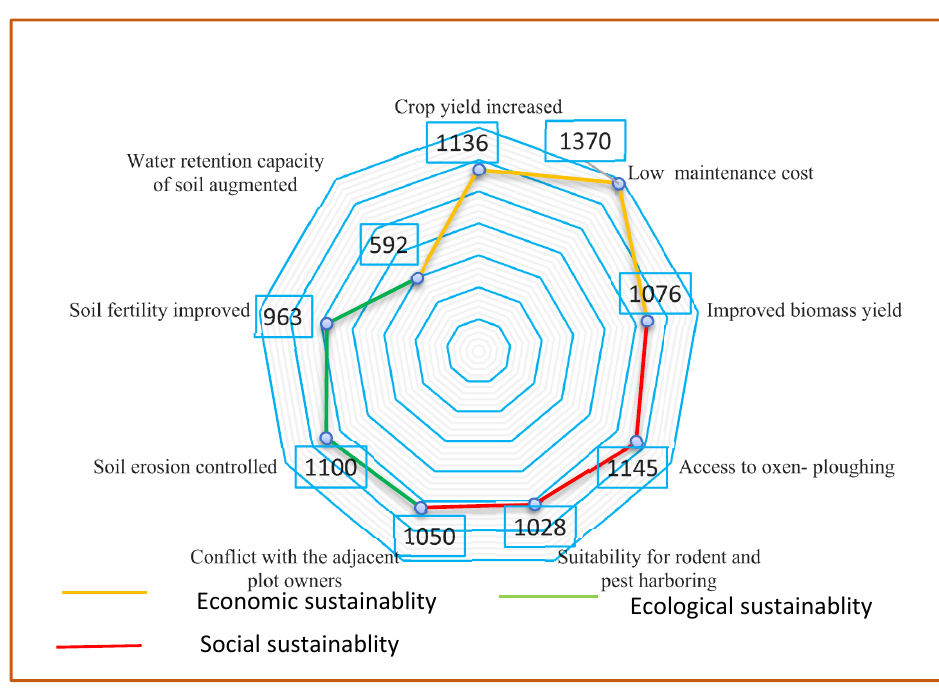
Figure 5. Sustainability of physical practices.